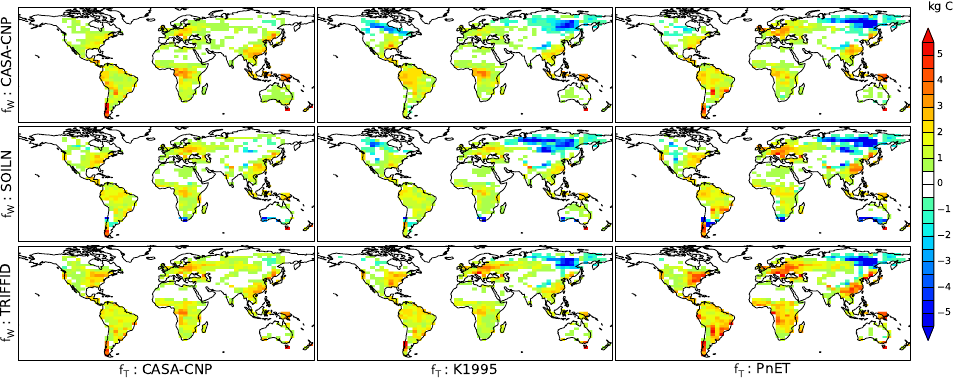
Fig. 7. Cumulative NEA during historical simulations as represented by the difference in the average land carbon between the periods 1996–2005 and 1850–1859 in CN simulations. Each sub-panel corresponds to a single combination of response functions as indicated.